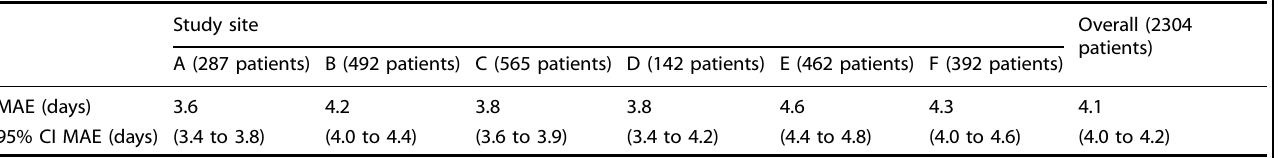
Table showing the performance of MultiPlane for individual study sites included in the INTERBIO-21st study throughout the second and third trimester, coded A – E. MAE Mean Absolute Error, CI Con fi dence Interval, GA Gestational